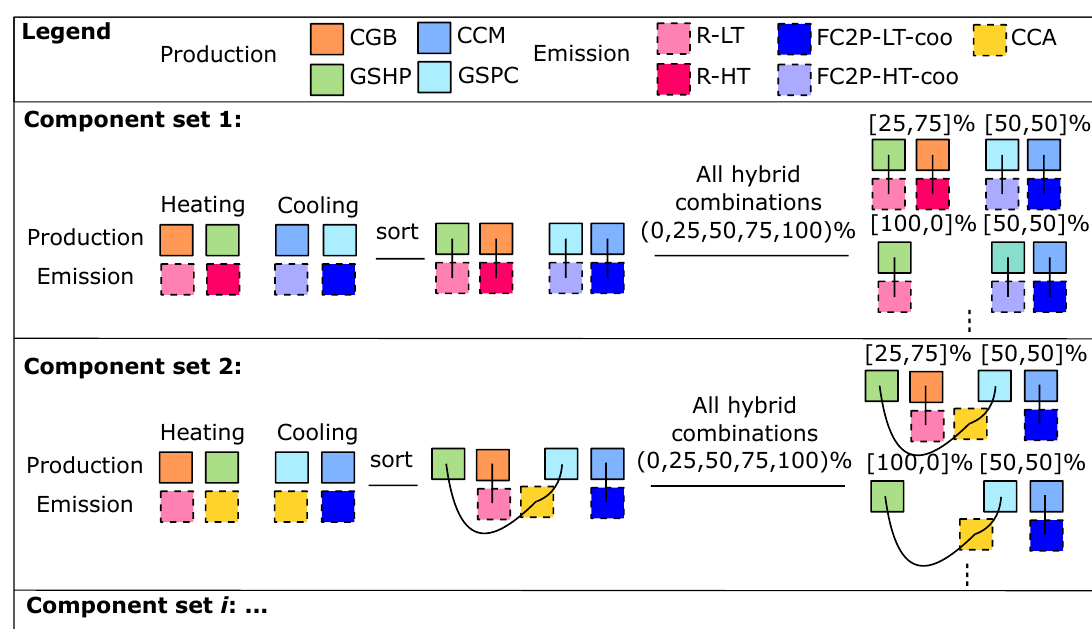
Figure 2. Illustration of how different HVAC scenarios composed of two heat and two cold production devices, each coupled to its own emission